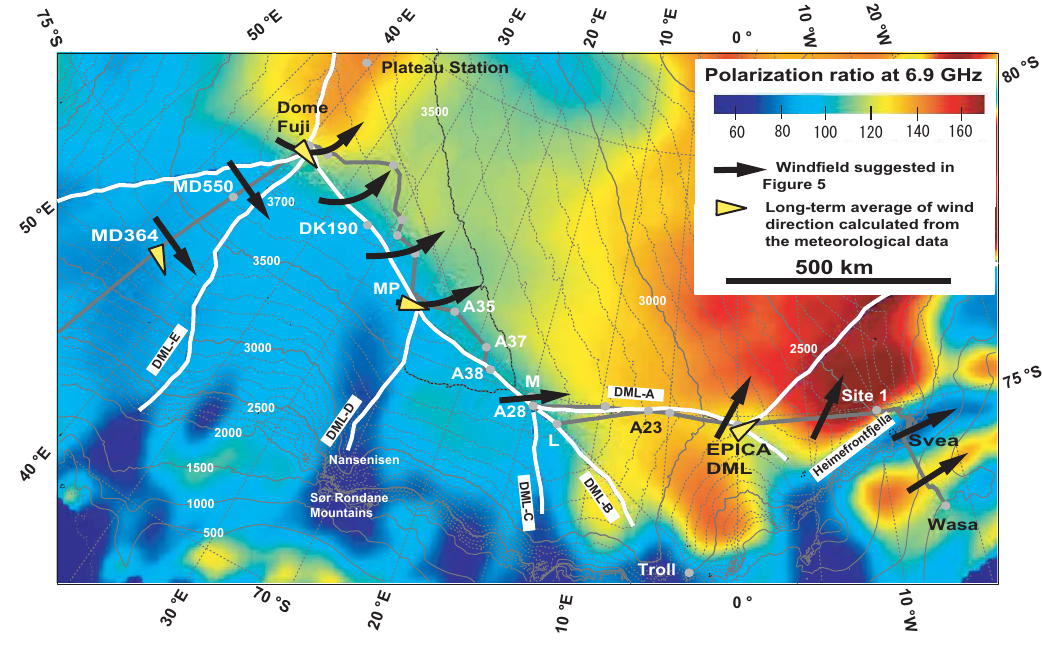
Fig. 7. Distribution of the polarization ratio of passive microwave data at 6.9GHz. Data were obtained from the Advanced Microwave Scanning Radiometer for EOS (AMSR-E), which was developed by JAXA for use on board the EOS satellite that has been operating since 2002. Previous studies (Surdyk and Fily, 1993, 1995) suggested that the polarization ratio at frequencies lower than 10GHz is an indicator of the number of layers per unit depth of strata to a depth of ∼ 2m. Lower/higher values mean fewer/more layers in the strata, which would qualitatively suggest that the accumulation rate is higher/lower. In the area between Dome Fuji and MP, the distribution of the polarization ratio closely resembles that of the accumulation rate shown in Fig. 10. The ice divide branch DML-A between site A28 and EPICA DML is within an area of higher polarization ratio. In addition, the legs of the Norwegian-USA traverse from Troll Station to Plateau Station is also within an area of higher polarization